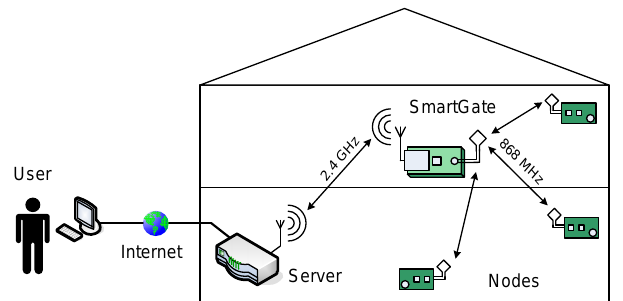
Figure 2. Whole system